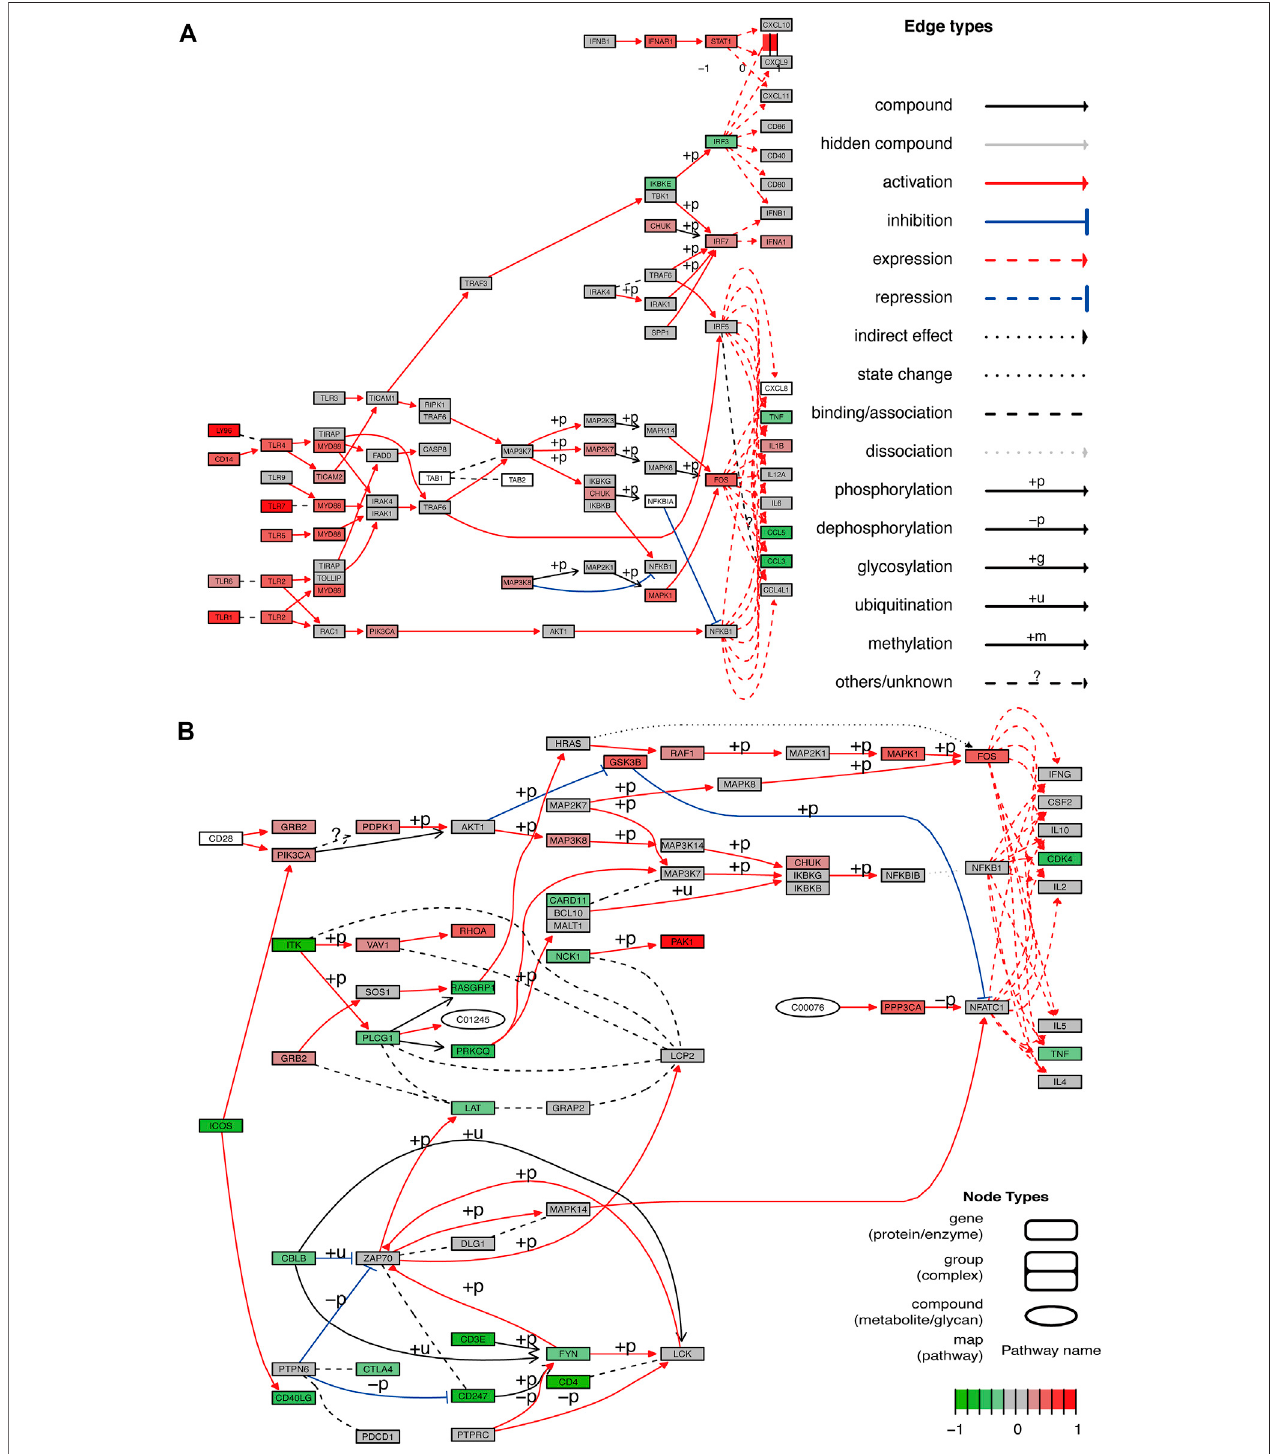
FIGURE 6 | Pathway diagram. (A,B) Two pathway diagrams composed of two major networks are constructed using DEGs.